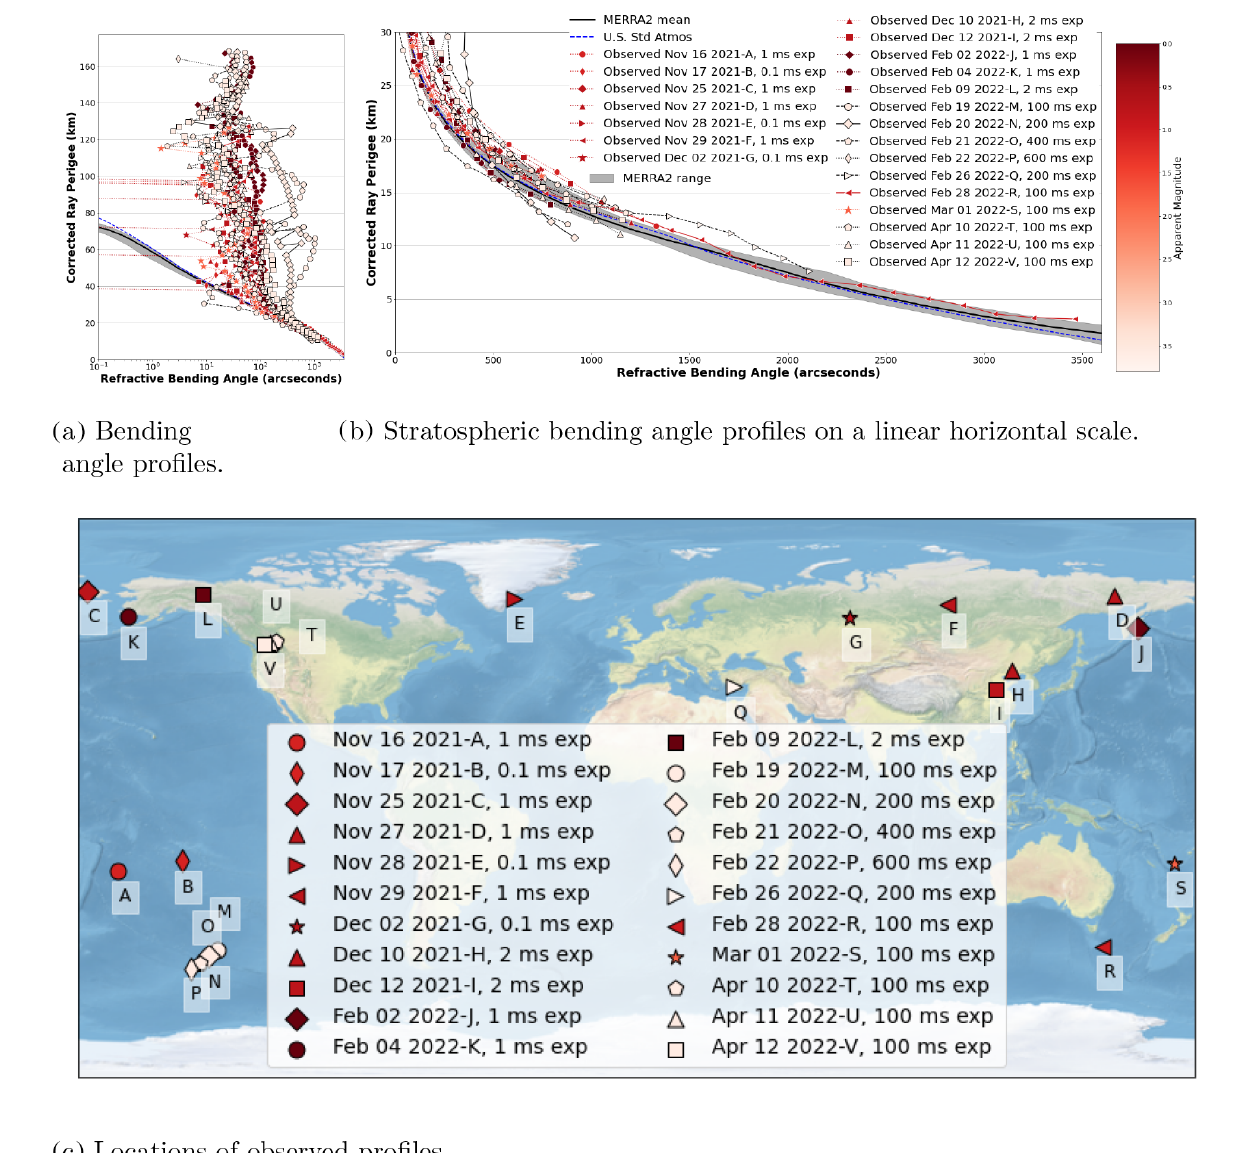
Figure 4. GEOStare SV2 observations in panels (a) and (b) and their locations in panel (c) . See Fig. 3 for details. Here the stars captured range from dim to bright with apparent magnitudes 3.6 to −